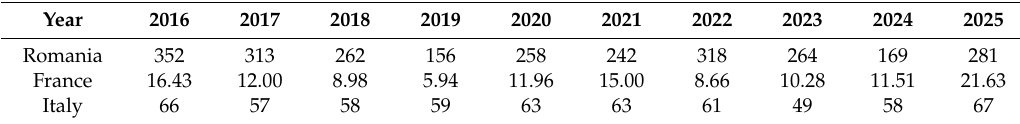
Table 13. Potential of biodiesel from soybean (thousand tons). Source: authors’ own calculation based on